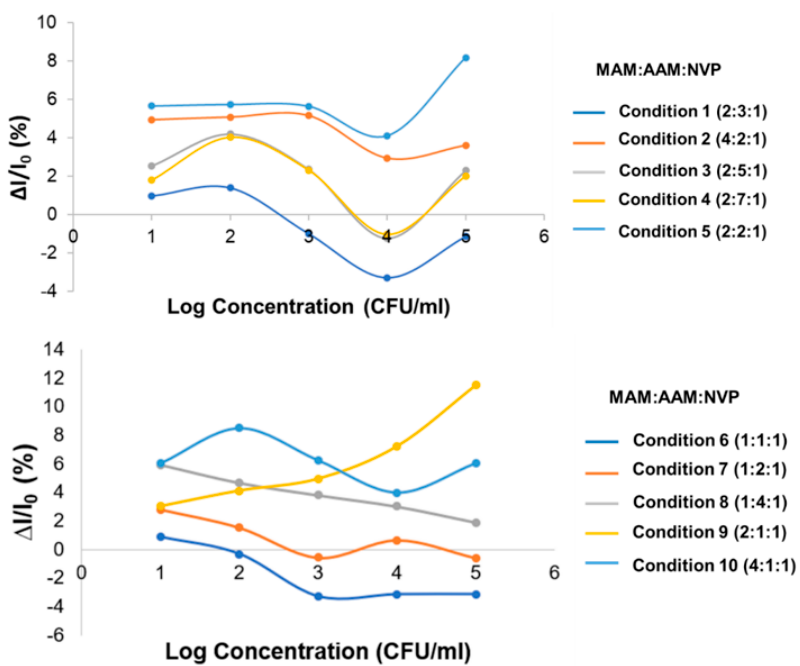
Figure 4. Comparison of linearity range for conditions 1 to 10 on the carbon electrode. Table 3. The current data of conditions 1–10 on the carbon electrode.